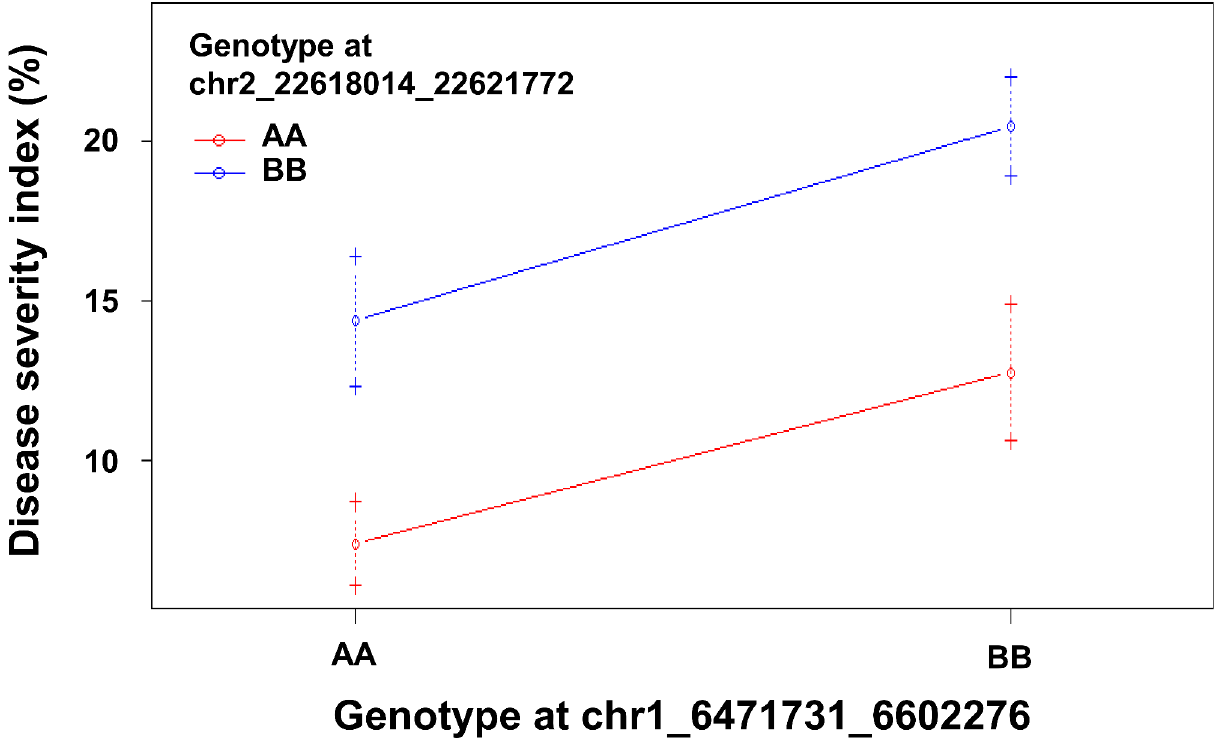
Fig. 4 Interaction plot for qBK1.8 and qBK2.1. chr1_6471731_6602276 and chr2_22618014_22621772 are the bin markers nearest the peaks of qBK1.8 and qBK2.1 , respectively. Genotypes AA and BB are ‘Budda’ and ‘TK16’ homozygotes,